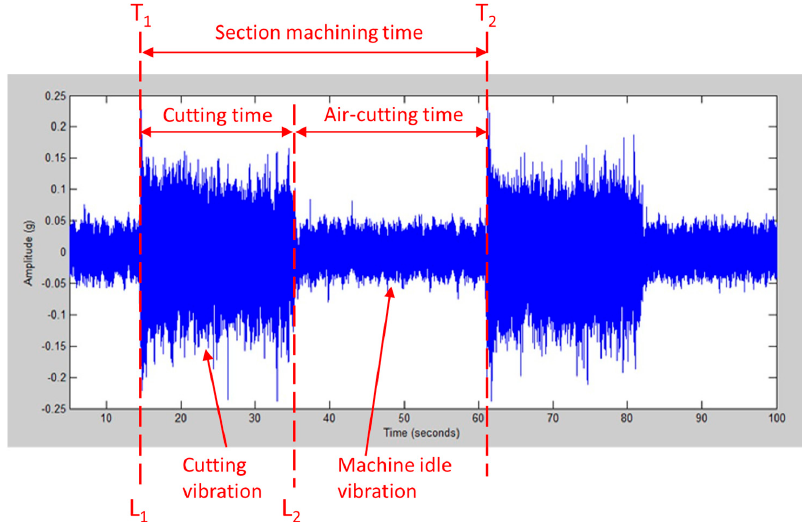
Figure 2. Cutting/no-cutting vibration